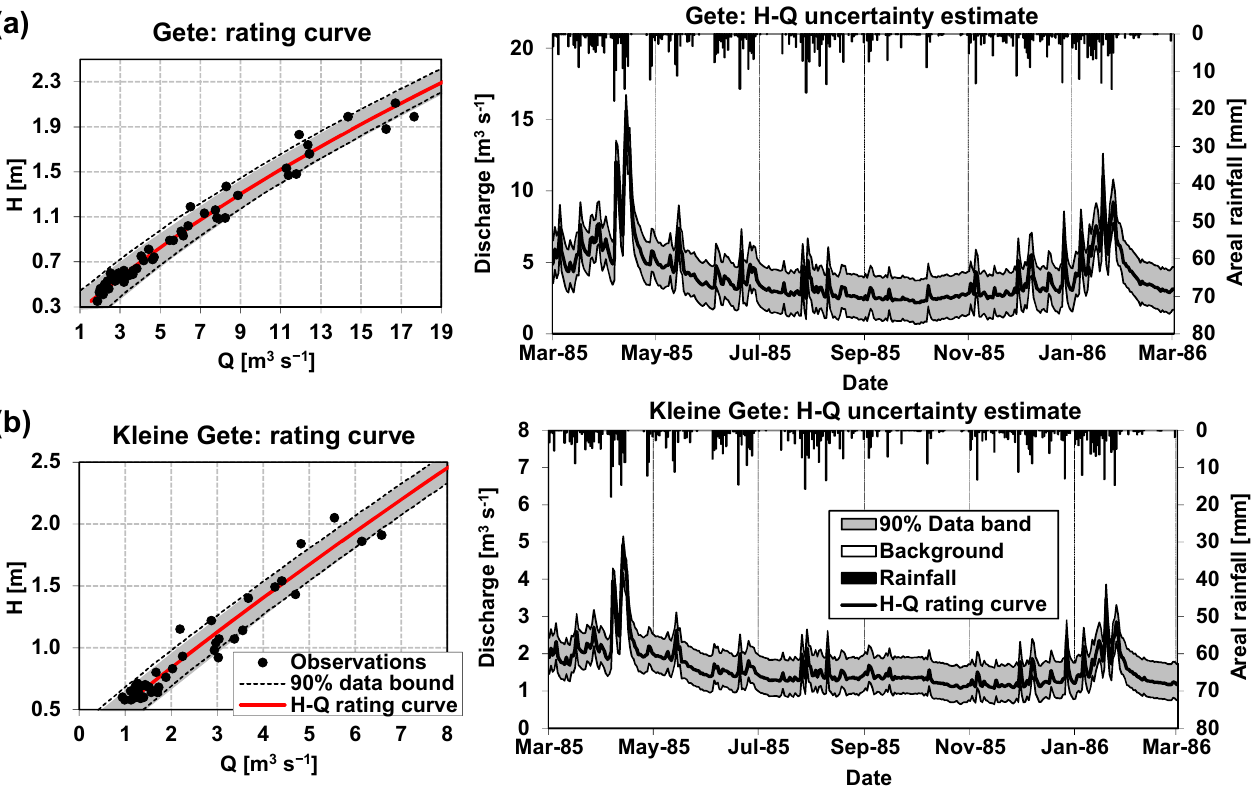
Figure 2. Rating curves and associated 90% prediction intervals and estimated hydrograph and associated data uncertainty band for ( a ) the Gete station; and ( b ) the Kleine Gete station.